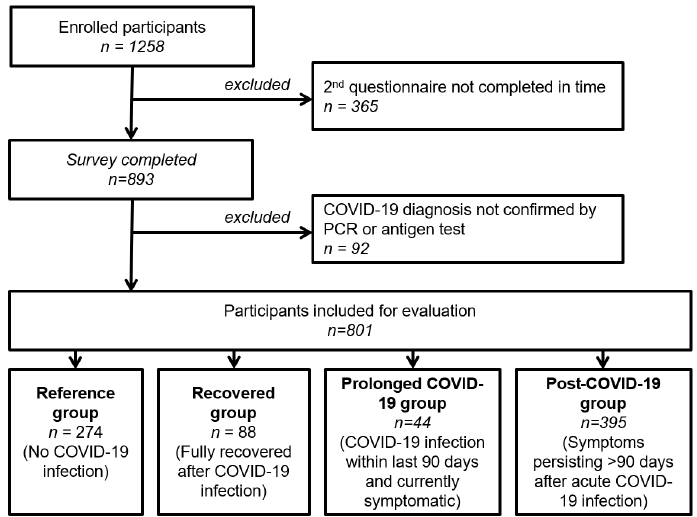
Figure 1. Flowchart of patient